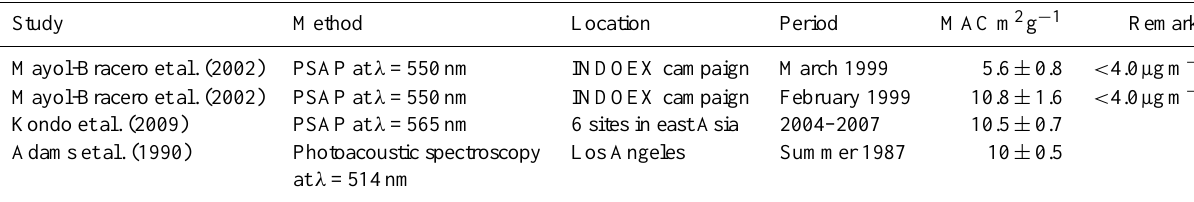
Table 1. Mass Absorption Cross-section values reported in the